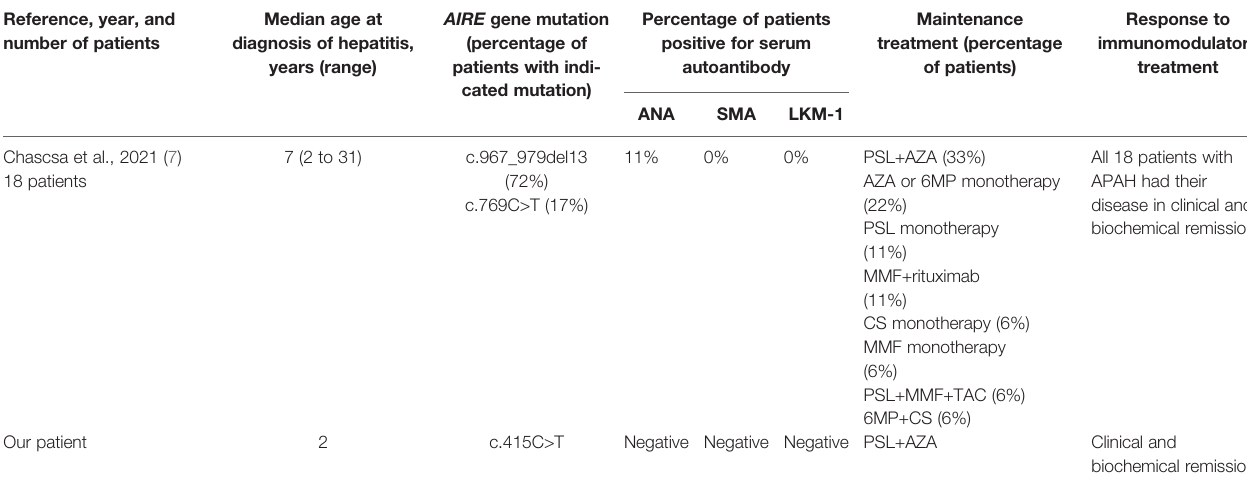
TABLE 2 | Clinical, genetic, and treatment aspects of APAH patients with AIRE gene mutation in a reported series and in our patient. Reference, year, and Median age at number of patients diagnosis of hepatitis,